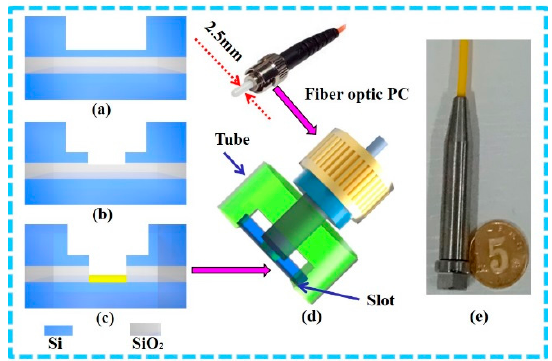
Figure 4 . Schematic of fabrication and assembly process of the fiber optic EFPI sensor: ( a ) Etching of a deep hole on the handling layer of the silicon-on-insulator (SOI) wafer, ( b ) Etching of a smaller hole in the bottom of the previous deep hole, ( c ) Removal of the oxide layer and sputtering of the gold film, ( d ) Assembly of the sensor probe, ( e ) Optical image of the sealed EFPI